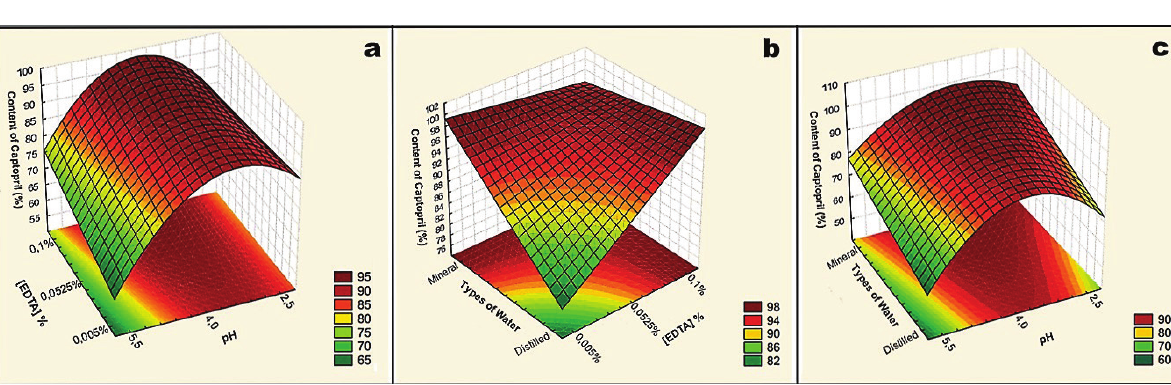
FIGURE 5 – Surface Response for a) pH x EDTA; b) type of water x EDTA c) type of water x